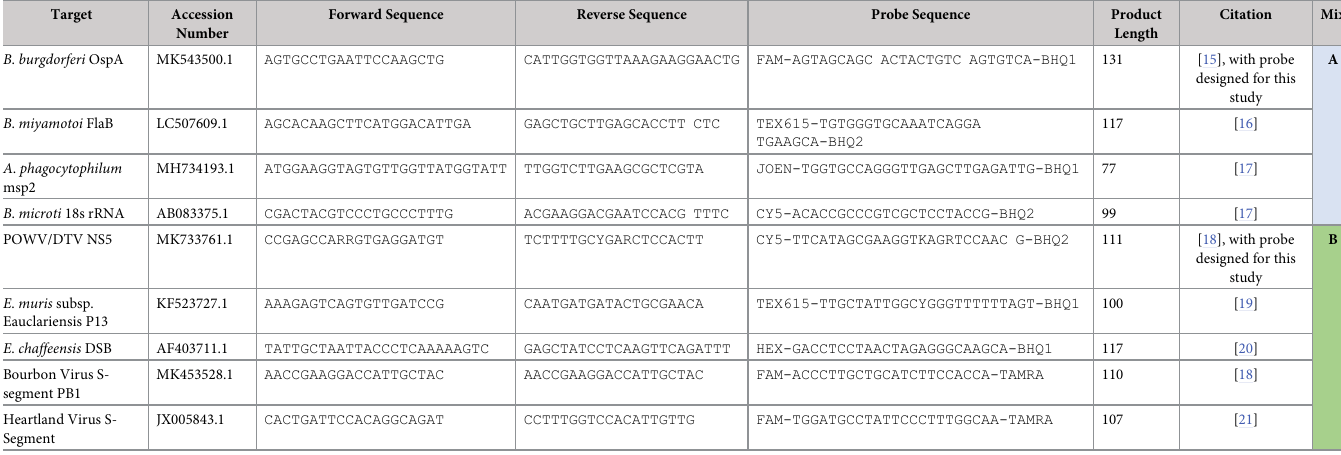
Table 1. Primers used for pathogen detection. The target genes, primer sequences, probe sequences with fluorophore/quencher combinations, and product lengths of the pathogen-detection primers used in this study. These were combined in to Mix A and Mix B, with each tick sample run once with each primer combination to assess the presence of nine